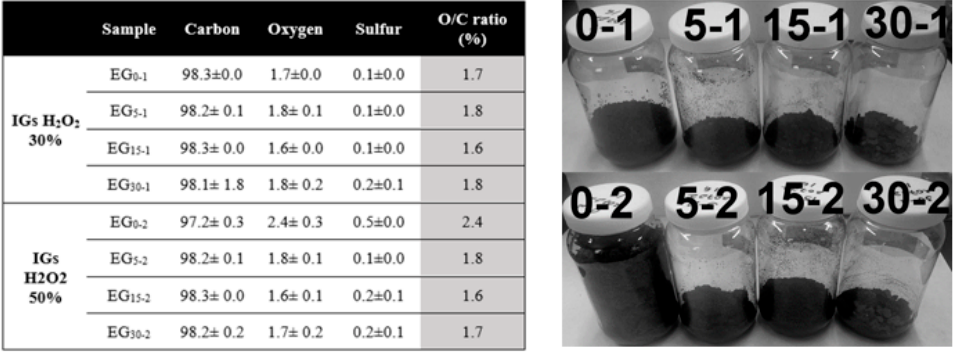
Figure 7. Elemental analyses performed on expanded graphites (in weight %), carbon/oxygen ratio, and a comparative image of prepared IGs. Series one corresponds to EG prepared from IGs using 30% hydrogen peroxide solutions (series two were obtained using H 2 O 2 50%).